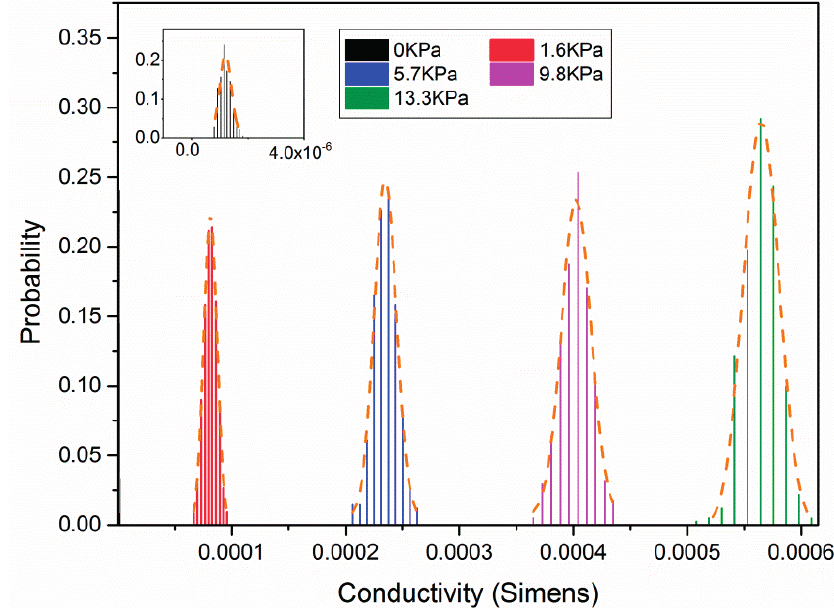
Figure 4. The statistical distribution of the measured conductance result at five different pressure